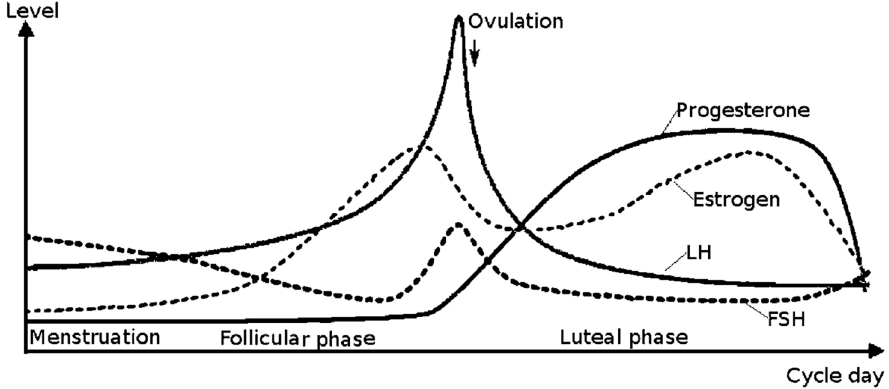
Figure 1. Levels of hormones during the phases of a woman’s monthly cycle (Weschler,